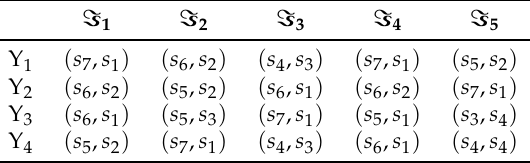
Table 1. Decision matrix Q 1 by Z 1 .